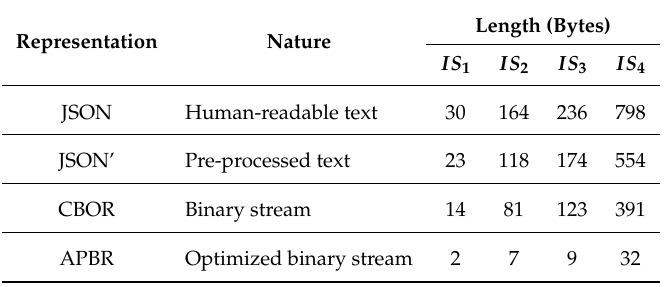
Table 4. Length comparison for different representations of four examples of sample